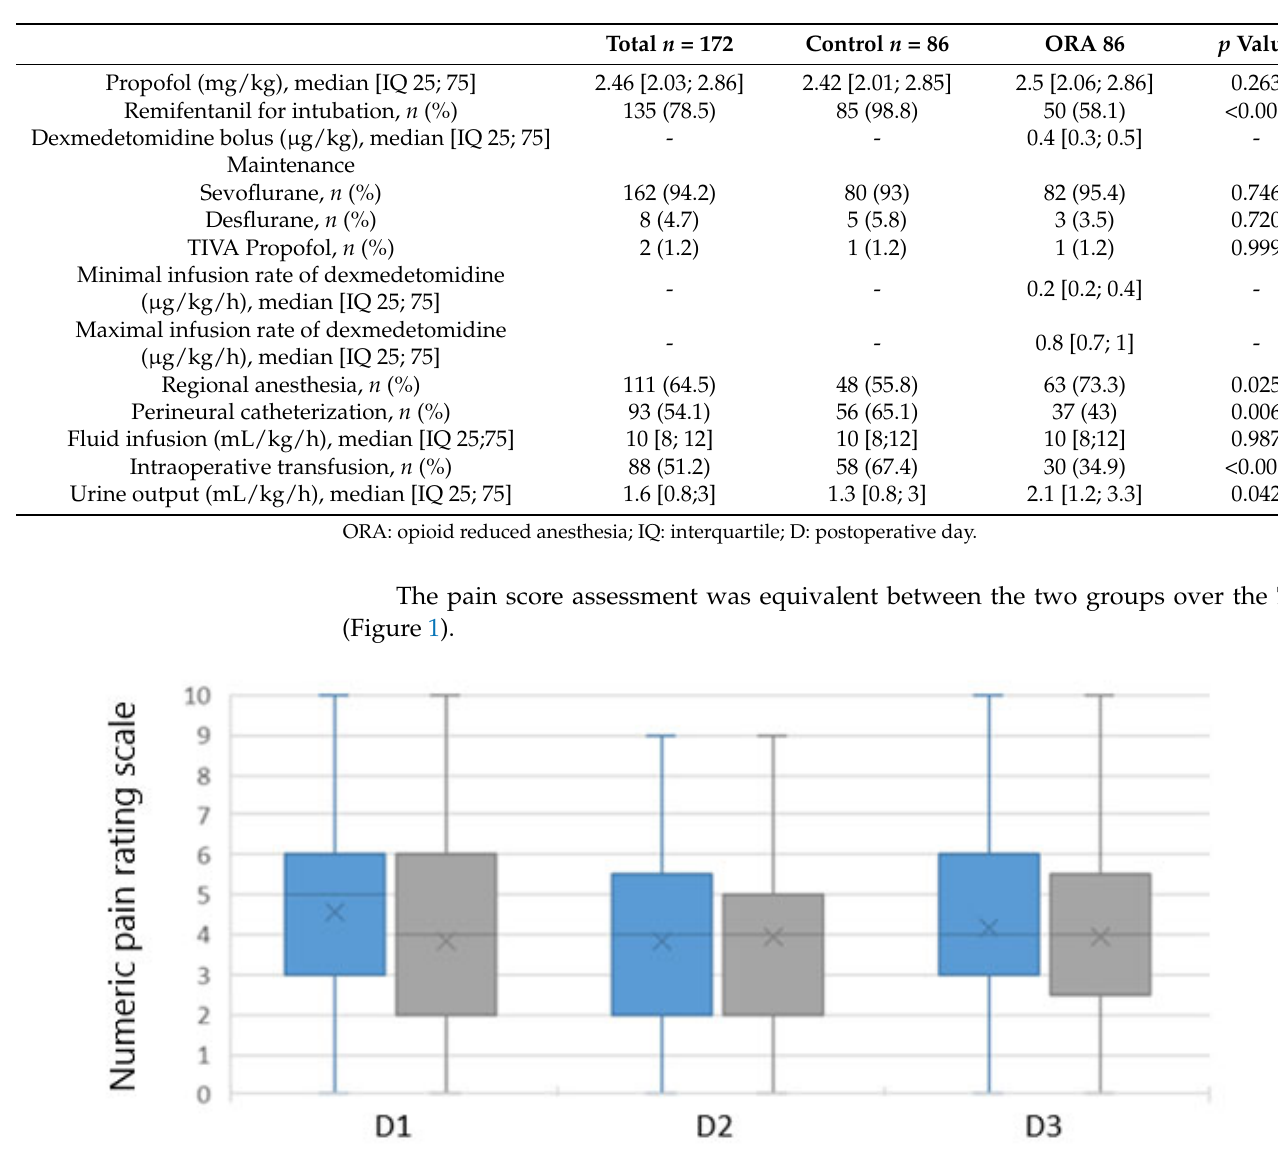
Table 2. Intraoperative events.